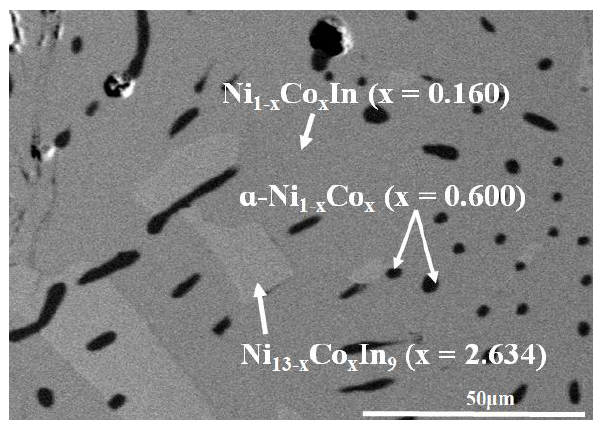
Figure 12. The BSE micrograph of No. 30 (Co25Ni45In35).